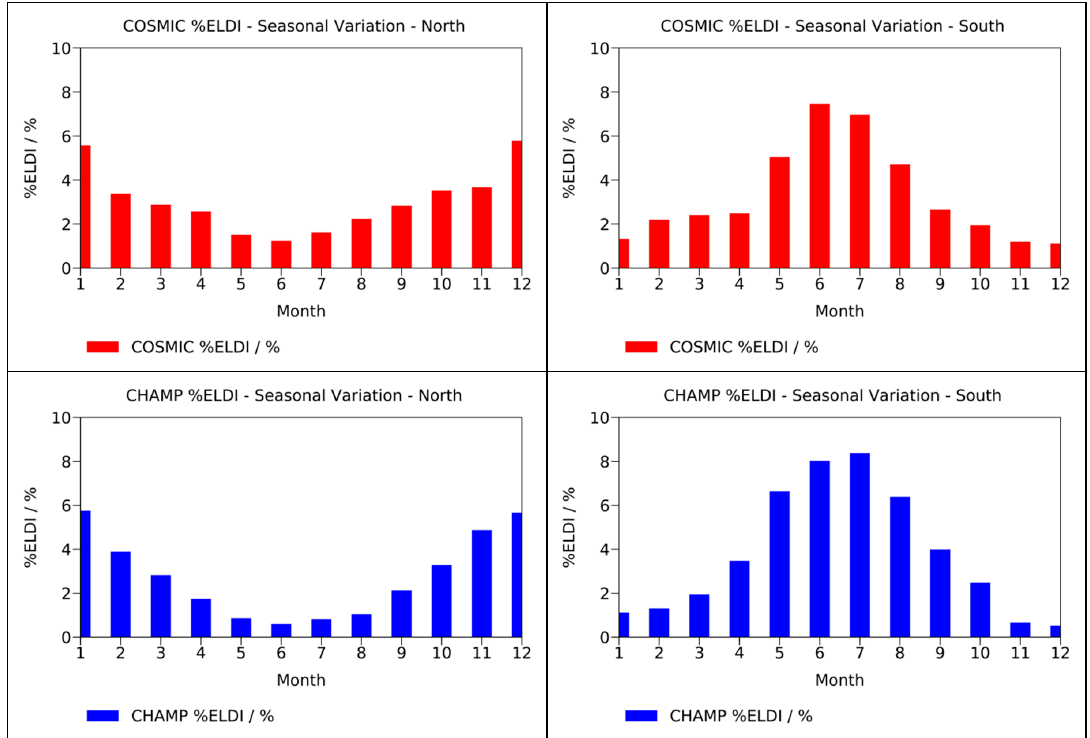
Figure 7. Seasonal variation of %ELDI. ( Top panels ) COSMIC (data from 2006 to 2018); ( bottom panels ) CHAMP (data from 2001 to 2008); ( left panels ) northern high latitude region; ( right panels ) southern high latitude region.